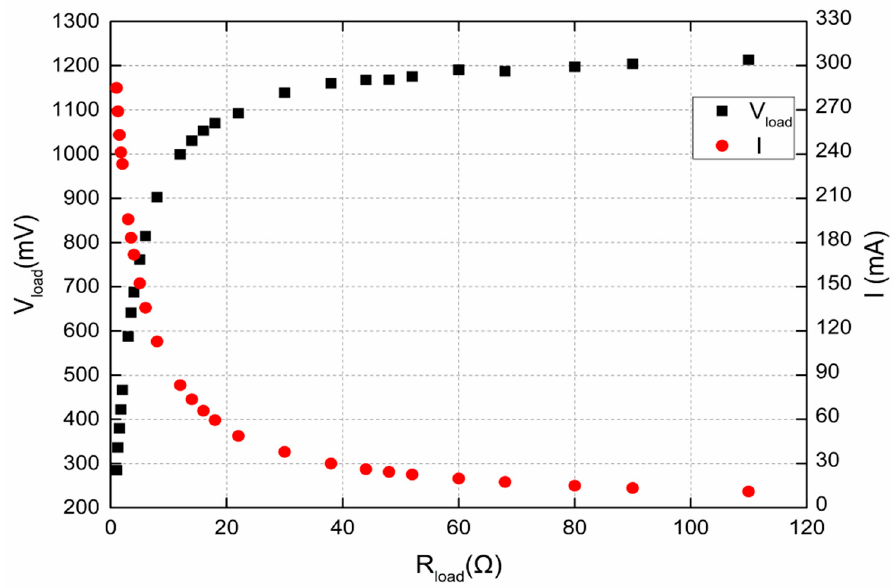
Figure 5. Change trends of V load and I with the load